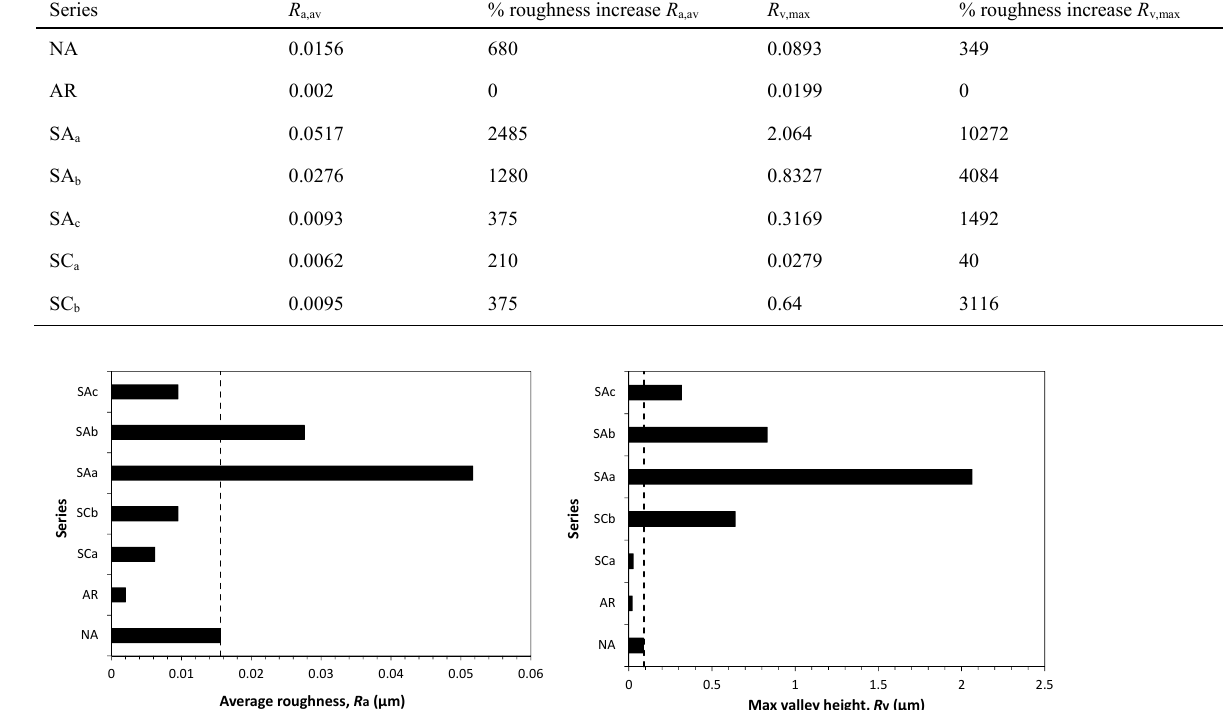
Table 3: Roughness parameters results.